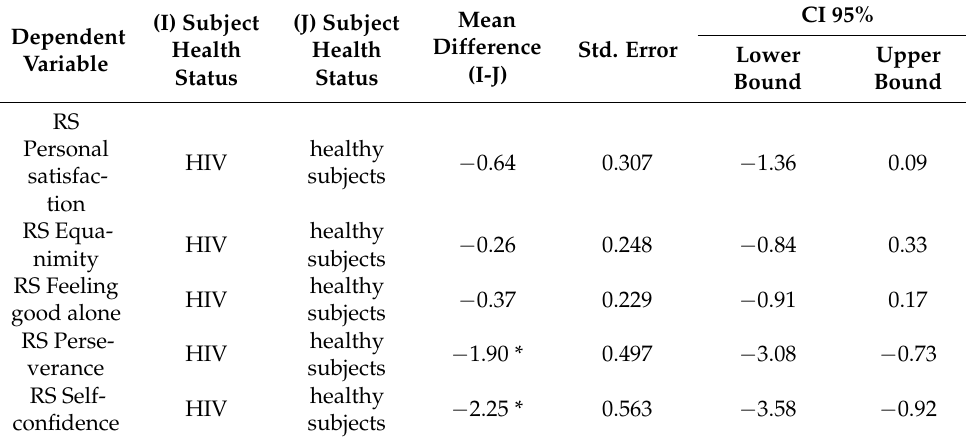
Table 7. Multiple comparisons: resilience factors.